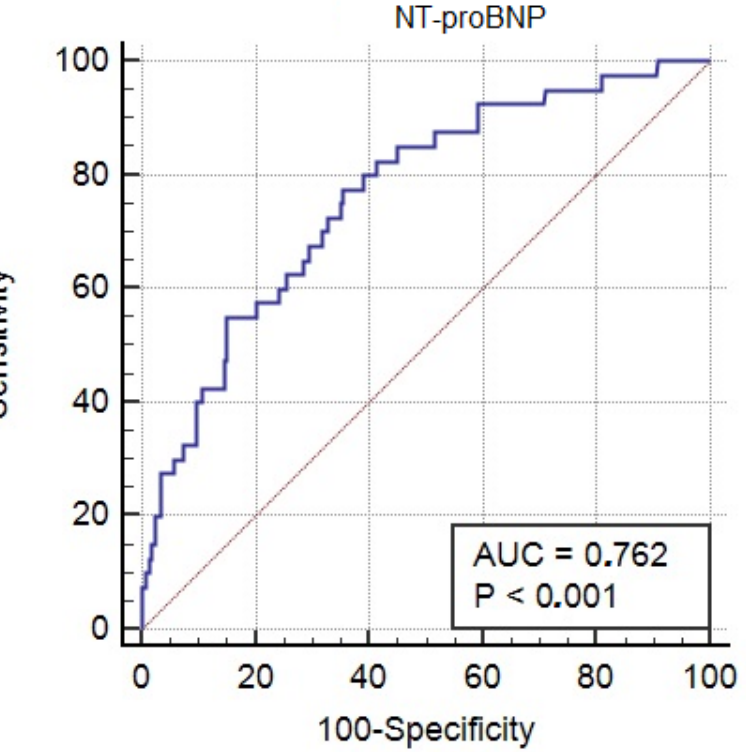
Figure 1. Area under the receiver operating curve for the main end-point (multiple organ dysfunction syndrome) for NtproBNP.